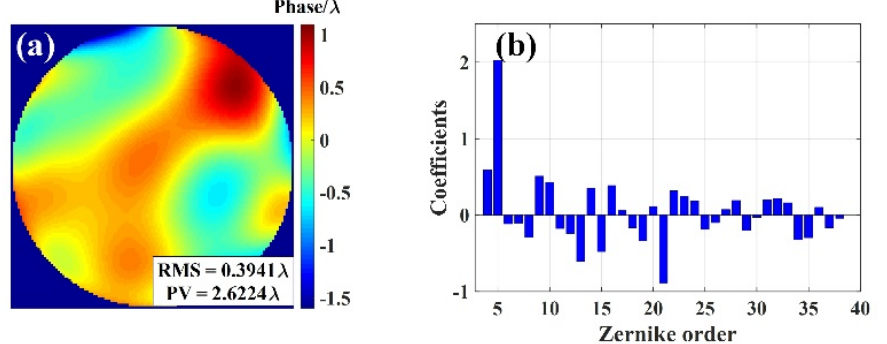
Figure 4. Incident wavefront and corresponding Zernike coefficients. ( a ) Incident wavefront. ( b ) Zernike coefficients.